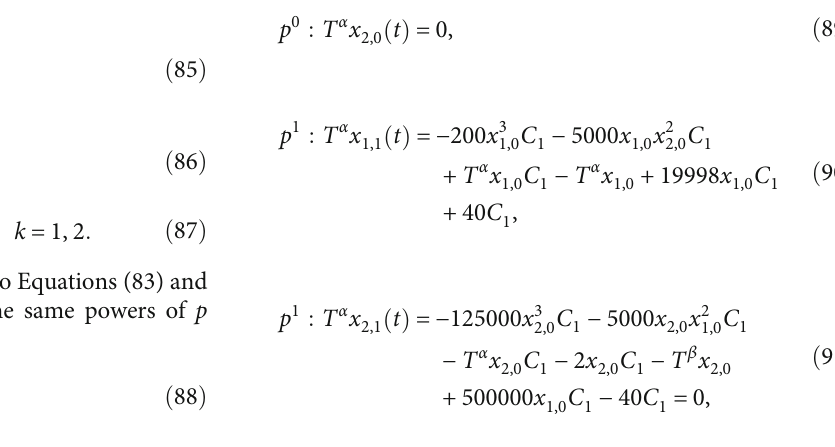
Figure 1: (a) Di ff erent values of α (OHAM-LS; α = 1 , dot; α = 0 : 9, dash; α = 0 : 8, dash dot; and α = 0 : 7, long dash) and Rk4 ( α = 1 , solid) at x (b) Di ff erent values of α (OHAM-LS; α = 1, dot; α = 0 : 9, dash; α = 0 : 8, dash dot; and β = 0 : 7, long dash) and RK4 ( α = 1 , solid) at x 2